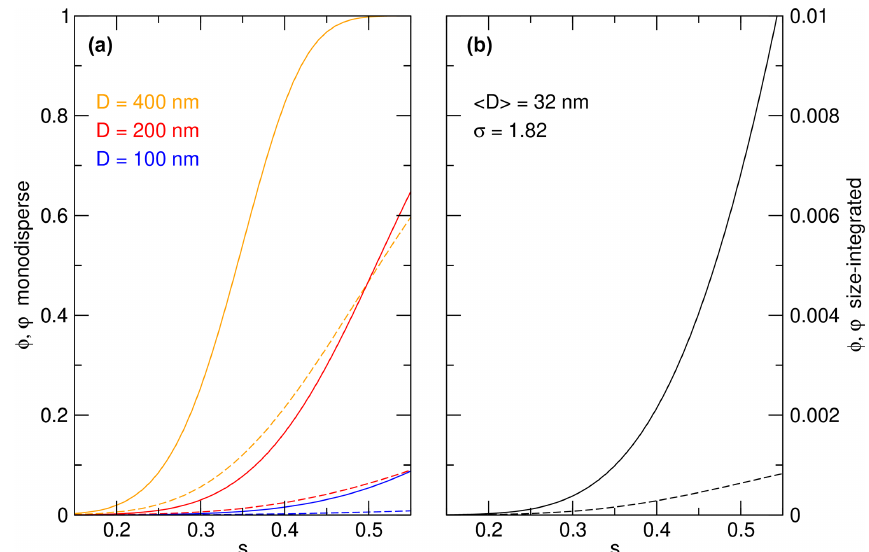
Figure 4. (a) The cumulative (solid curves) and differential AFs (dashed curves) for contrail-processed aircraft soot particles with mobility diameters of (orange) 400, (red) 200, and (blue) 100nm. (b) The cumulative (solid) and differential (dashed) AFs integrated over a population of contrail-processed aircraft soot particles with lognormal number size distribution parameters indicated in the legend. Differential AFs are computed based on an s -grid with constant spacing (cid:49)s = 0 . 01.